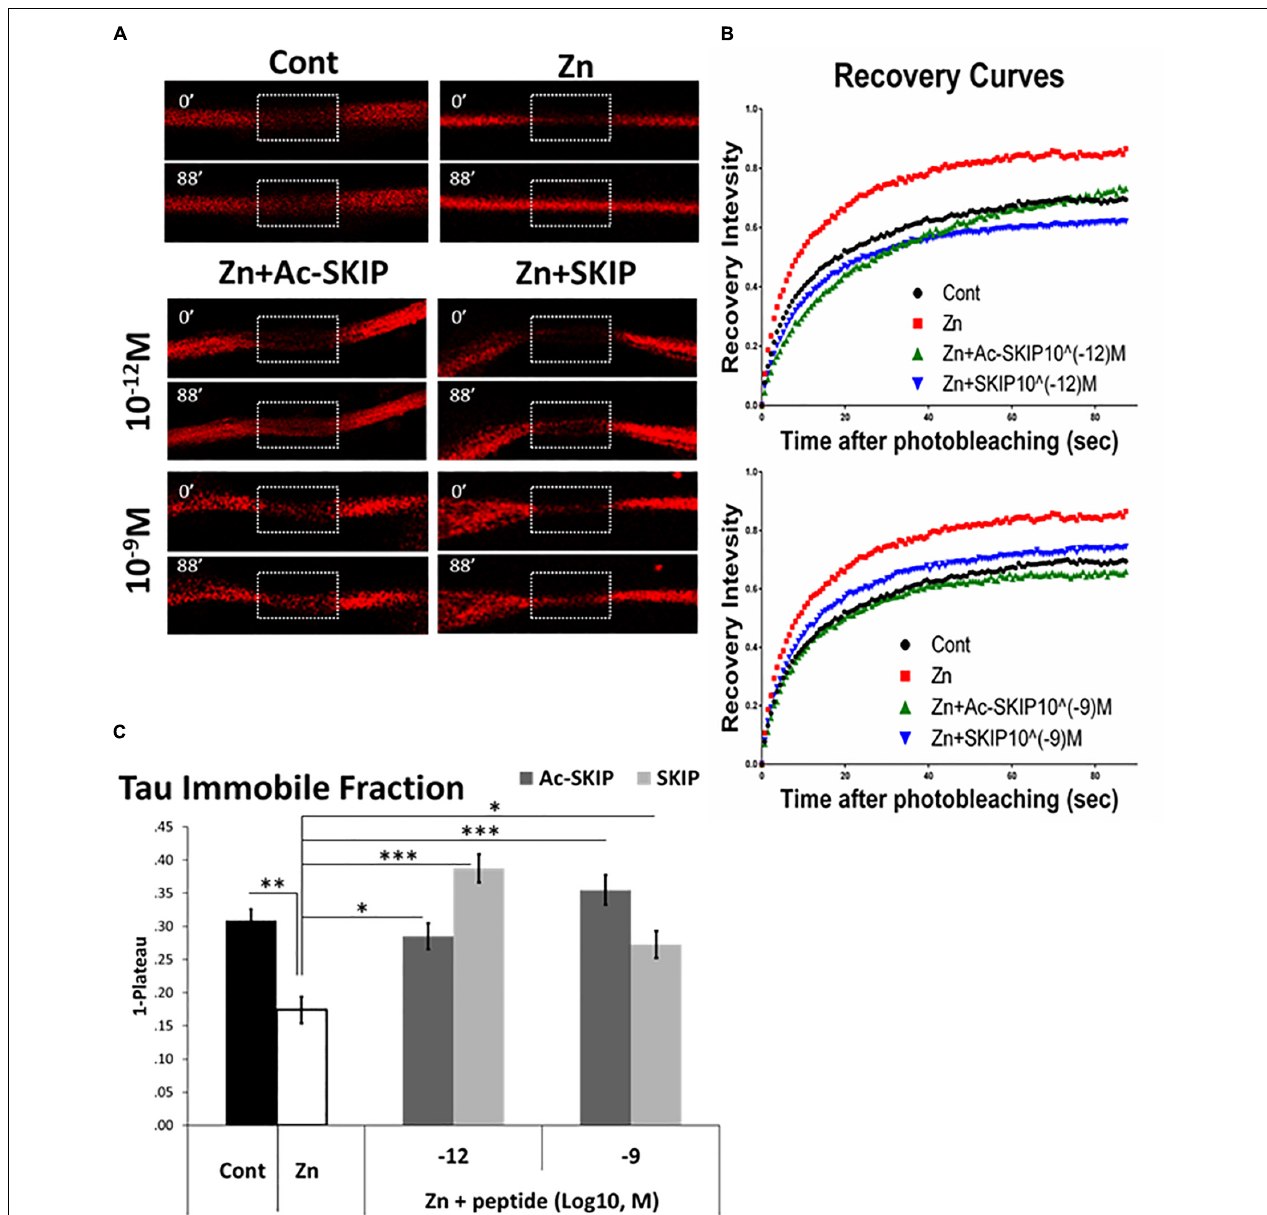
FIGURE 3 | Ac-SKIP and SKIP protective effect on Tau interaction with MTs, assessed by FRAP analysis. FRAP was performed on differentiated neuroblastoma N1E-115 cells after 2 h of treatment with extracellular zinc (400 µ M) alone or together with Ac-SKIP or SKIP (10 − 12 M and 10 − 9 M). (A) Representative images of FRAP and fluorescence recovery of mCherry molecules conjugated to Tau. Marked squares represent the regions of bleaching immediately after photo-bleaching (0’–0 s after bleaching) and subsequent fluorescent recovery (88’–88 s after bleaching). (B) Obtained data of fluorescent recovery were normalized and recovery curves were built according to one-phase exponential association (see section “Materials and Methods”). (C) The graph represents the fitted data (by one-phase exponential association, see section “Materials and Methods”) of immobile fractions (collected on 88 s after photobleaching). Statistical analysis was performed by One-way ANOVA with Tukey HSD. Statistical significance is presented by ∗ P < 0.05, ∗∗ P < 0.01, ∗∗∗ P < 0.001. Control, n = 82; Zn, n = 43; Zn + Ac-SKIP 10 − 12 M, n = 44; Zn + SKIP 10 − 12 M, n = 79; Zn + Ac-SKIP 10 − 9 M, n = 76; Zn + SKIP 10 − 9 M, n =